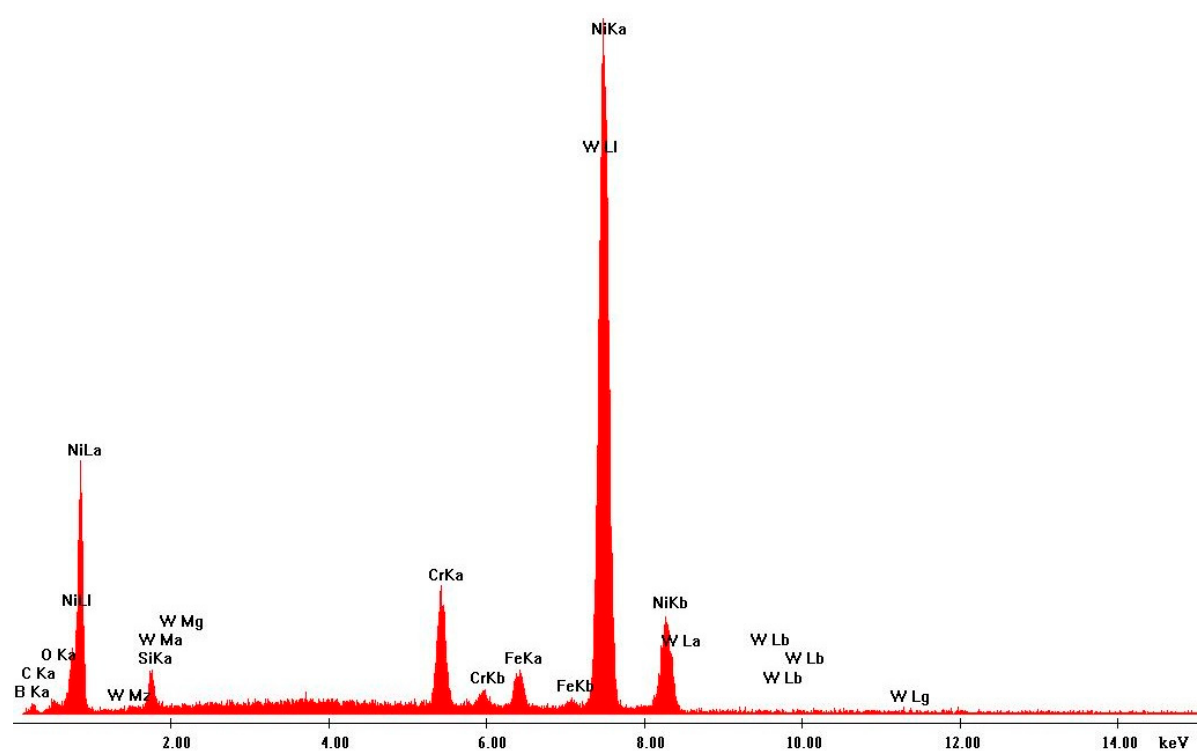
Figure 7. EDS analysis results: Raw Powder 2 (tungsten carbide–nickel alloy).